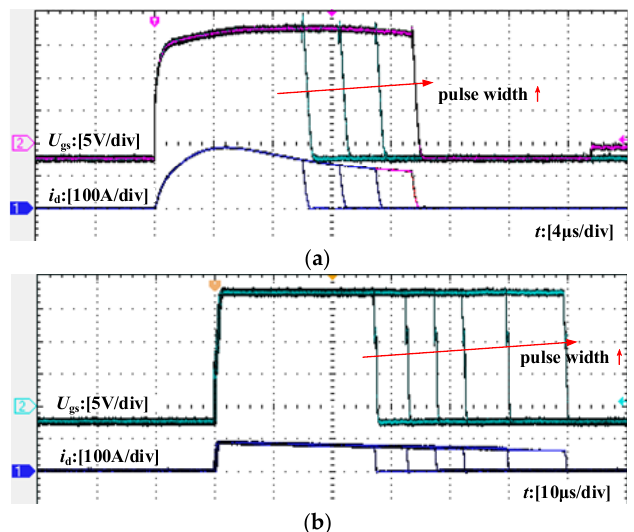
Figure 10. Short-circuit waveforms of U gs , and i d under different pulse width: ( a ) wave of SiC MOSFET; ( b ) wave of Si MOSFET.